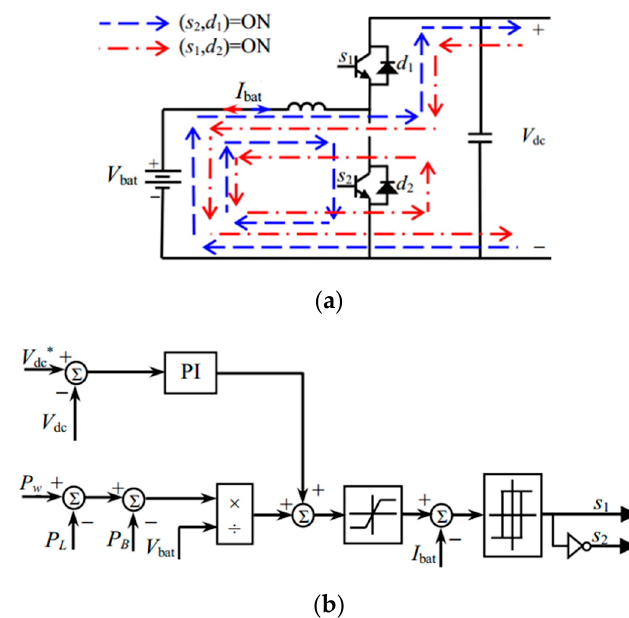
Figure 5. Battery storage system: ( a ) Charge-discharge operation; ( b ) control system.